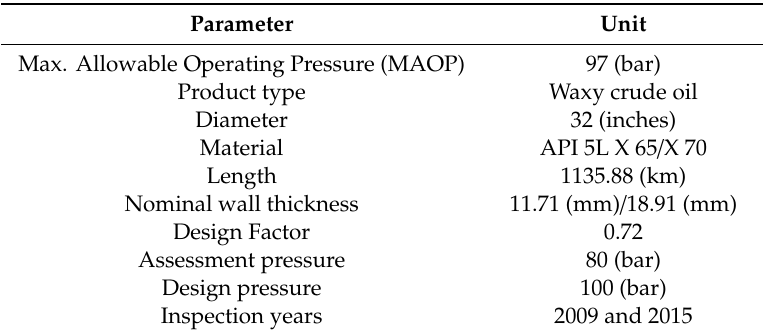
Table 1. Characteristics of collected pipeline